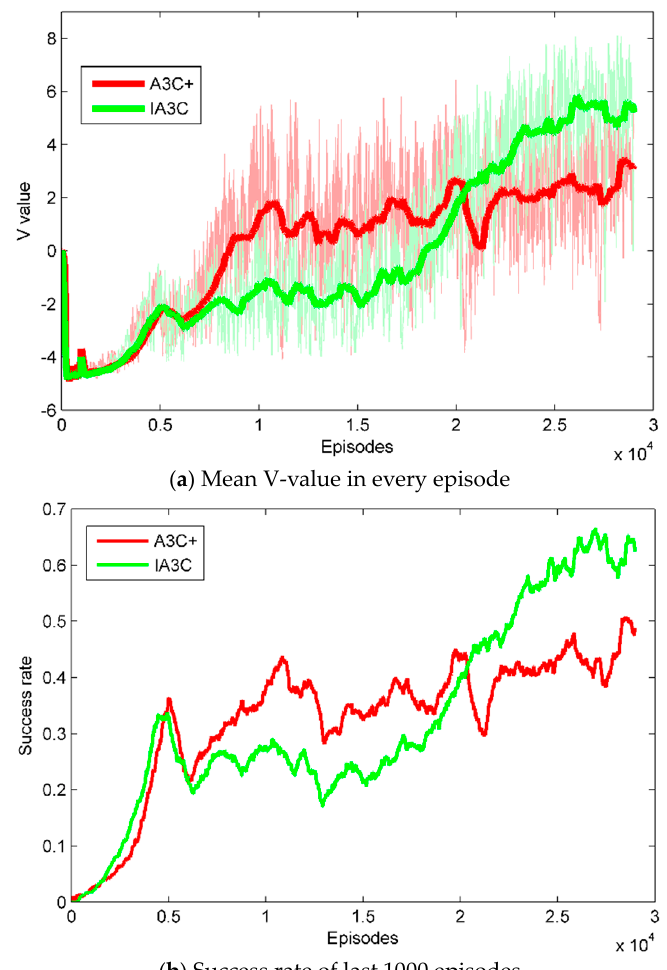
Figure 8. The performances of IA3C and A3C+ in the training phase.